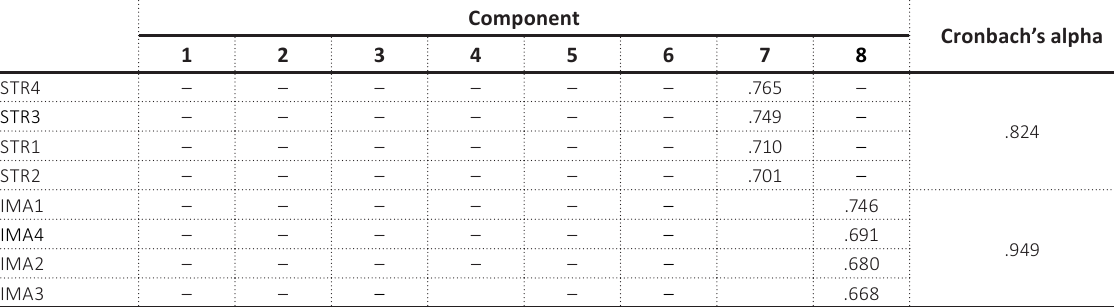
Table 4. Reliability and convergence of the scale